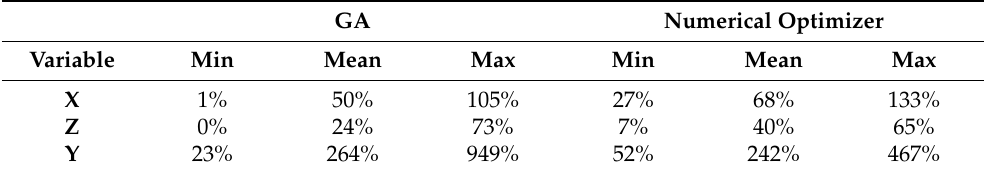
Table 7. Total changes, given by different optimizers.